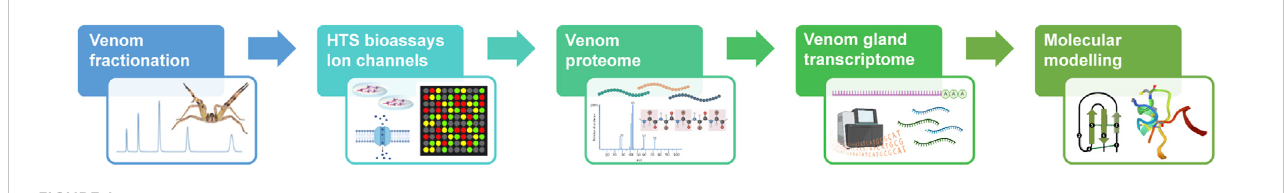
FIGURE 1 Flowchart of the venom peptide discovery pipeline applied in this study. Expanding from the traditional assay-guided fractionation, we applied HTS bioassays to characterize the pharmacology of venom peptides on multiple ion channels, followed by the identi fi cation of peptide masses and primary sequences using proteome and transcriptome. Ultimately, the three-dimensional structure of venom peptides was determined using in silico molecular